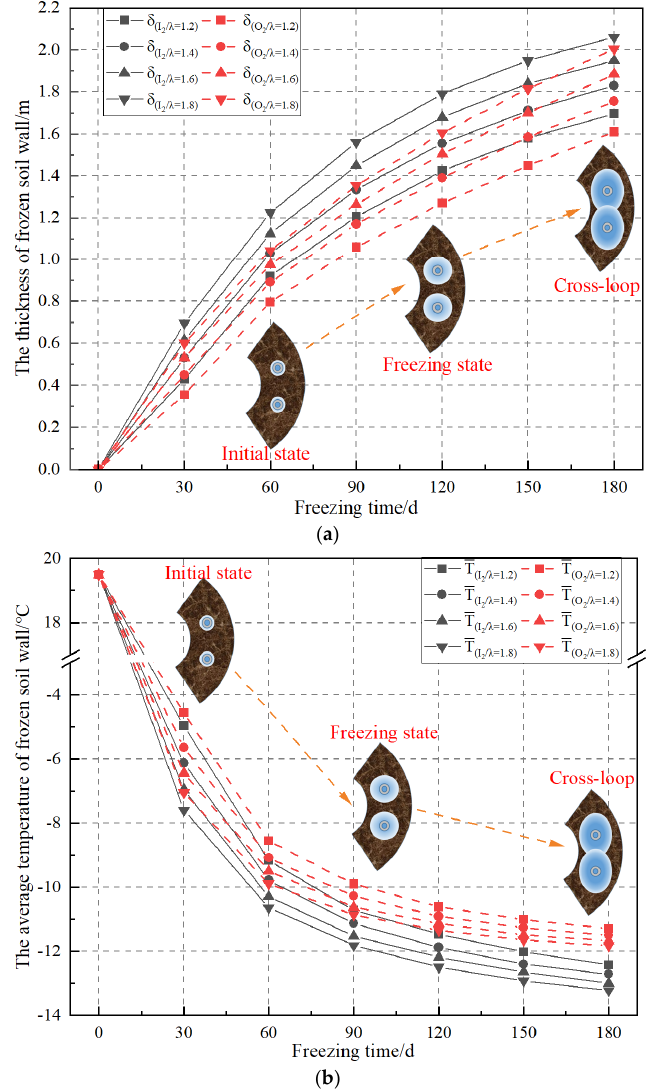
Figure 21. Variance in thickness and temperature of frozen soil wall under different thermal conductivity values of unfrozen soil: ( a ) the effect of thermal conductivity of unfrozen soil on the thickness of frozen soil wall, ( b ) the effect of thermal conductivity of unfrozen soil on the temperature of frozen soil wall.